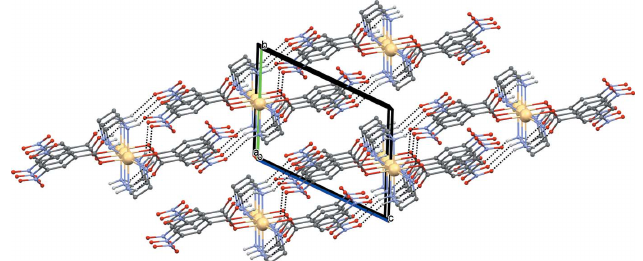
Figure 2 The crystal packing of the coordination complex [Cd(DNBA) 2 (en) 2 )] showing N—H (cid:2)(cid:2)(cid:2) O hydrogen bonds as dashed lines. For clarity, H atoms not involved in hydrogen bonding are omitted.